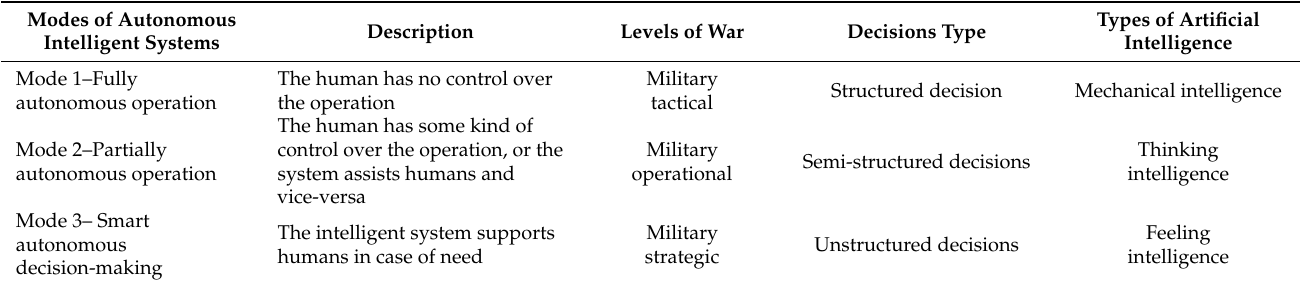
Table 3. Modes of autonomous intelligent systems in the defense